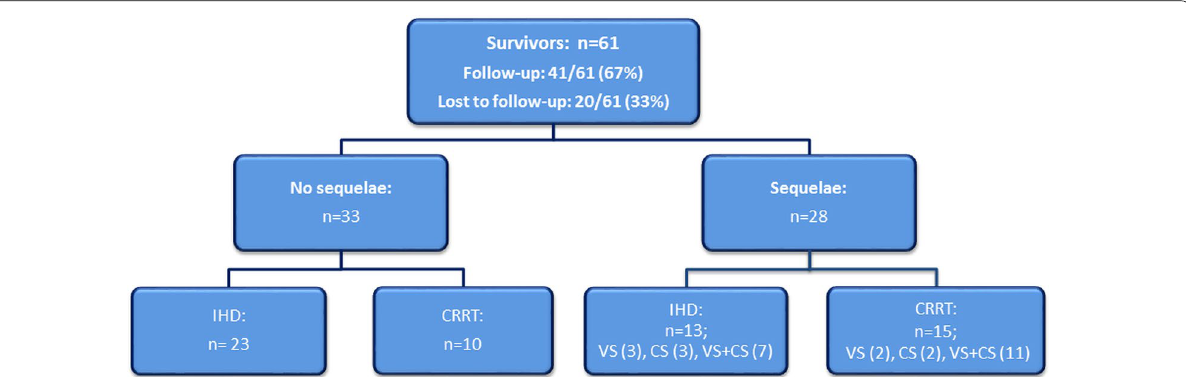
Fig. 2 Flowchart of the treatment outcome in the survivors of poisoning in the study (VS—visual sequelae, CS—central nervous system sequelae)